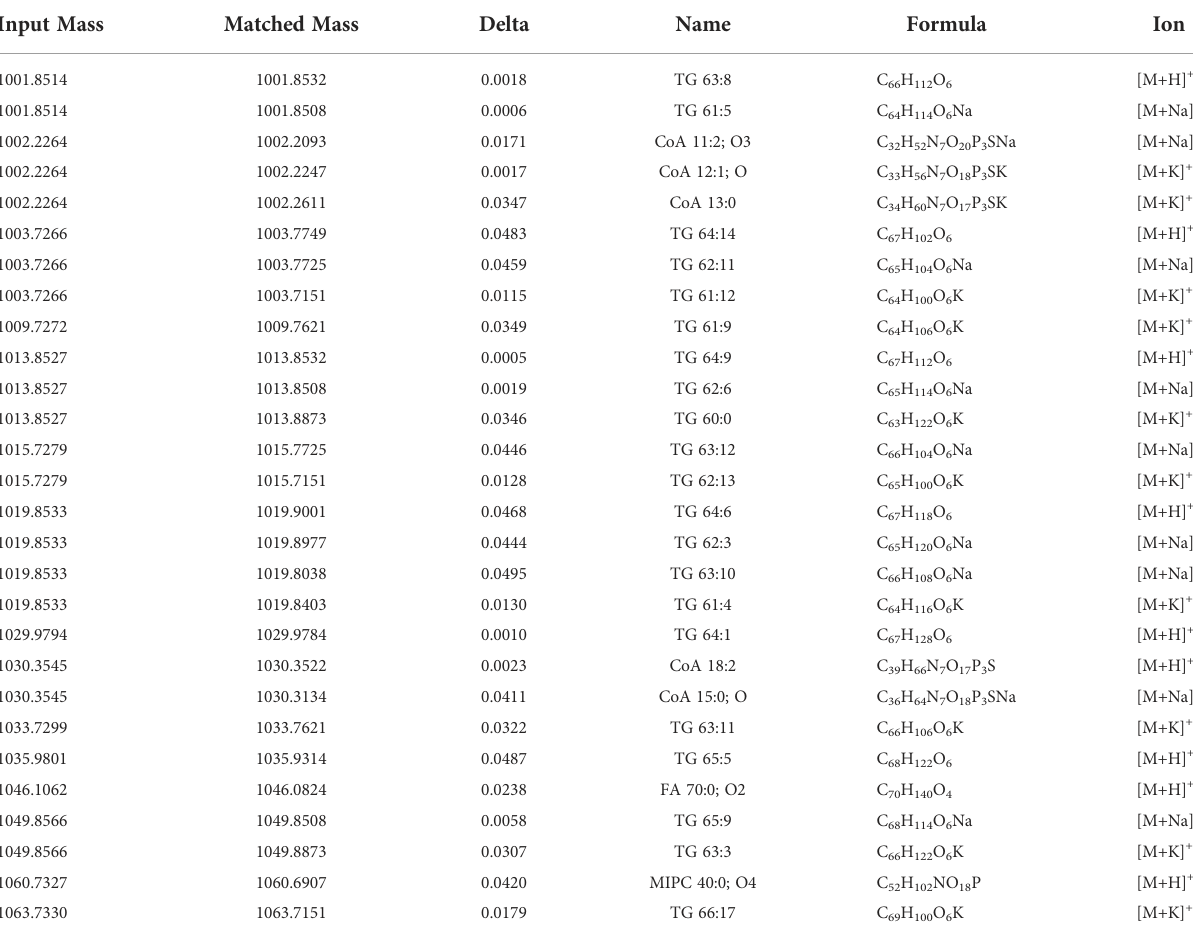
TABLE 1 LIPID MAPS database matching results.